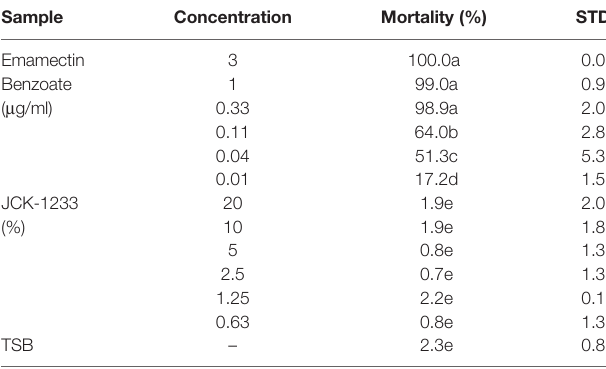
TABLE 3 | The in vitro nematicidal activity of JCK-1233 culture fi ltrates.